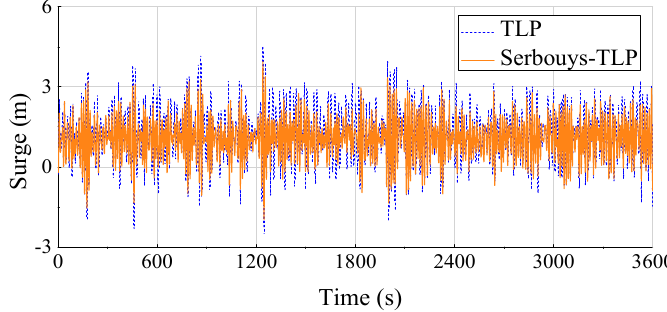
Figure 12. Surge response time history curve of wind turbines under the working sea state.